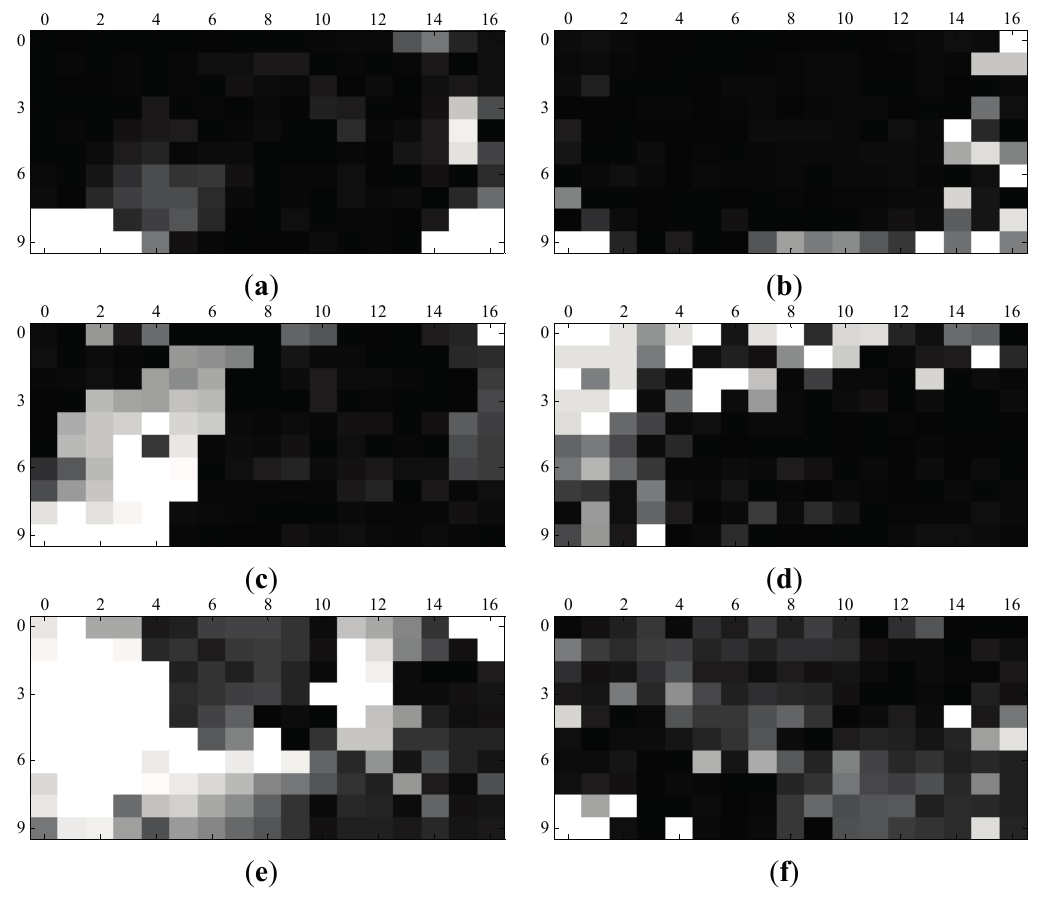
Figure 8. Angular error (AE) results. ( a , c , e ) The homing angular errors generated by warping method; ( b , d , f ) the homing angular errors generated by the proposed homing